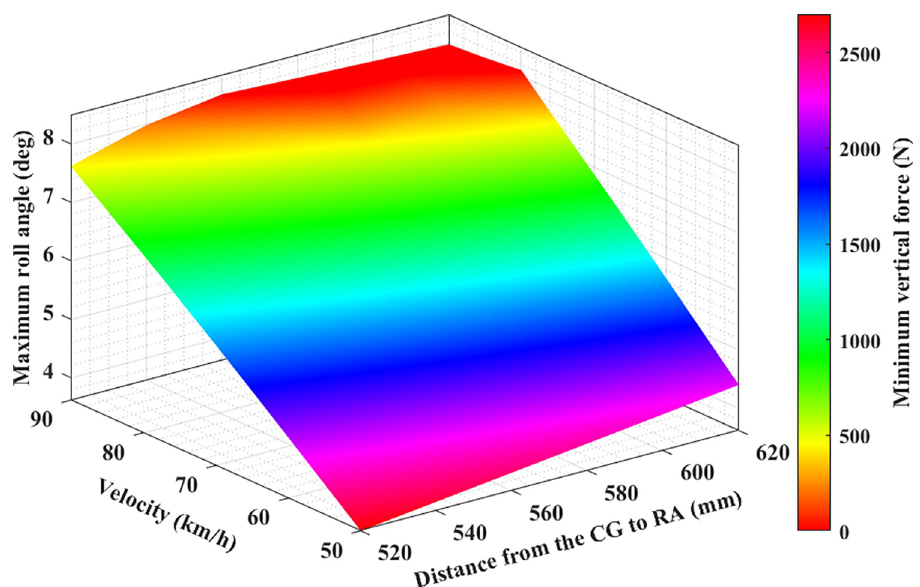
Fig 11. Limitation of rollover phenomenon (the first case).